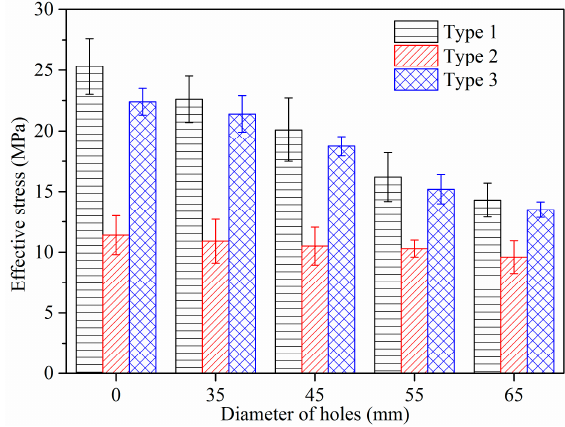
Figure 15. Effect of hole diameter on stress of different elements.